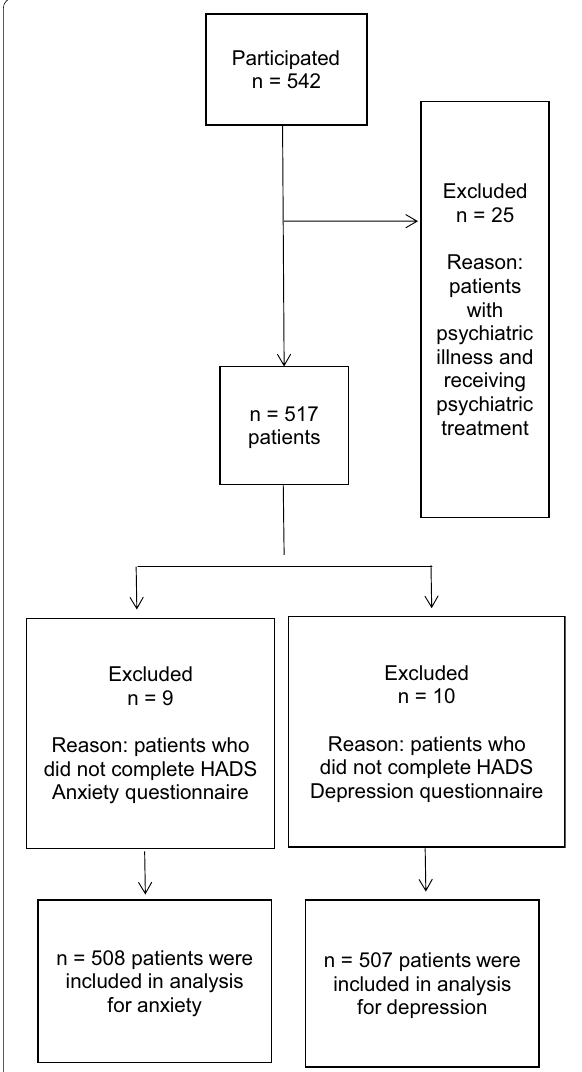
Fig. 1 Flowchart of patient selection. HADS Hospital Anxiety and Depression Scale